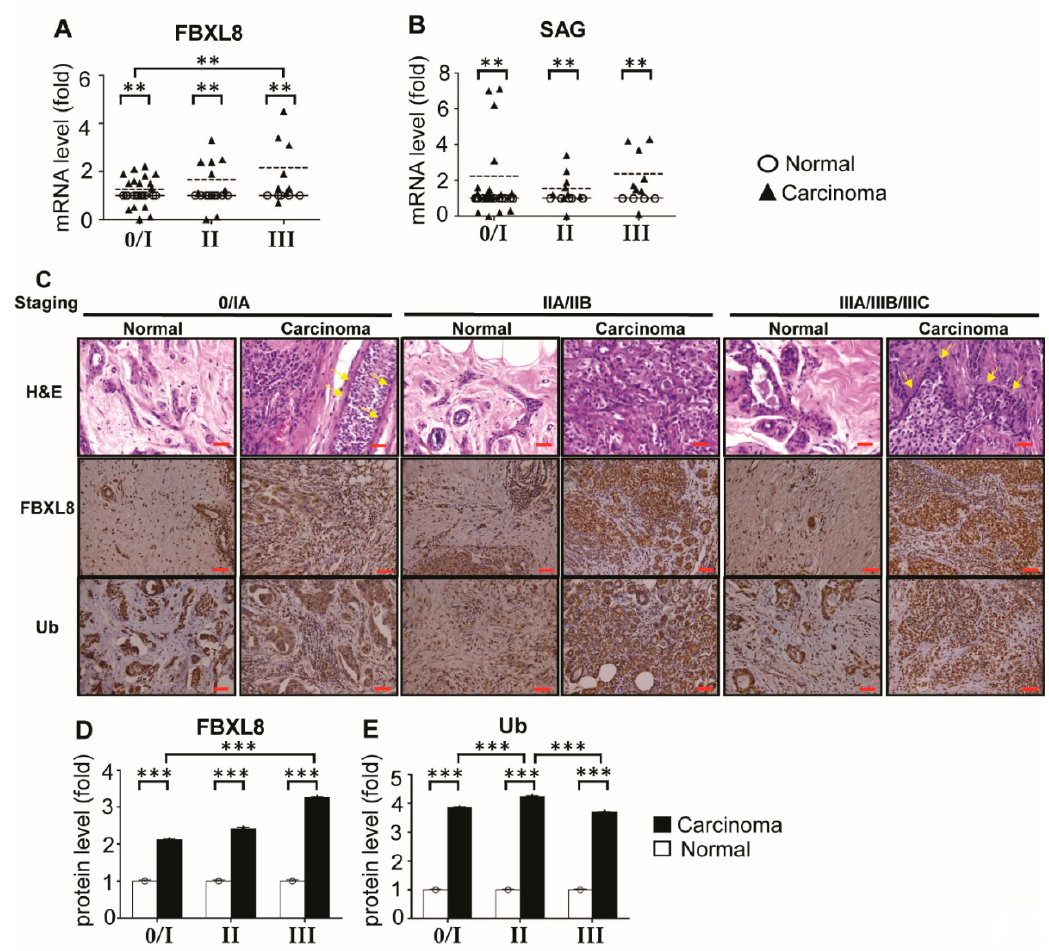
Figure 2. FBXL8 and key ubiquitin components are upregulated in human primary BRCA tissues. To clarify the potential of FBXL8-associated ubiquitination, analyses were performed by both qRT-PCR (A and B) and IHC (C). In total, 32 paired primary tissues are examined by qRT-PCR ( n = 64). ( A ) FBXL8 shows significant overexpression in carcinoma tissues, particularly in advanced stages (**, p < 0.01). ( B ) SAG (sensitive to apoptosis gene), a key component of SCF E3 ubiquitin ligase, was also elevated in BRCA tissues throughout all disease stages. FBXL8 or SAG gene was normalized against GAPDH housekeeping gene. Data are representative of means ± SD ( n = 3). **, p < 0.01; ***, p < 0.001. ( C ) H&E (hematoxylin and eosin) and immunohistochemistry (IHC) staining. Inflammatory cell infiltration is indicated with yellow arrows. Protein expression levels of FBXL8 and ubiquitin are examined in both normal ( n = 30) and carcinoma ( n = 30) breast tissues. The corresponding quantitative results of FBXL8 and ubiquitin in IHC are shown in panels ( D ) and ( E ), respectively. Consistent with the mRNA levels, the FBXL8 proteins are significantly upregulated in breast carcinoma tissues, as the cancer advanced into the later stages. Ubiquitin is also upregulated significantly in carcinoma tissues. The corresponding clinicopathological information for qRT-PCR analysis and IHC are shown in Figure S2 and Figure S3, respectively. Brown color indicates DAB dye-stained proteins of interest. Scale bar is 100 µ m, shown as the red color line (—). ***, p < 0.001.